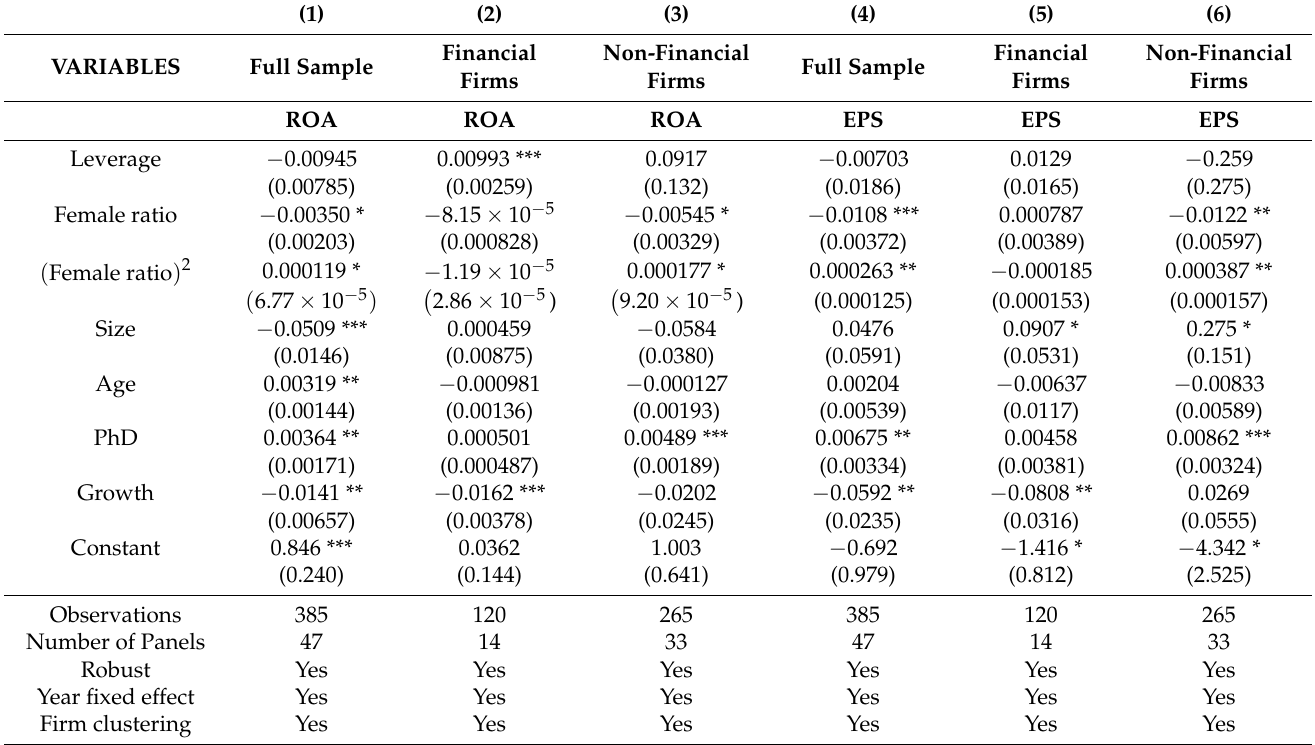
Table 8. The non-linear impact of gender diversity in BOD on ROA and